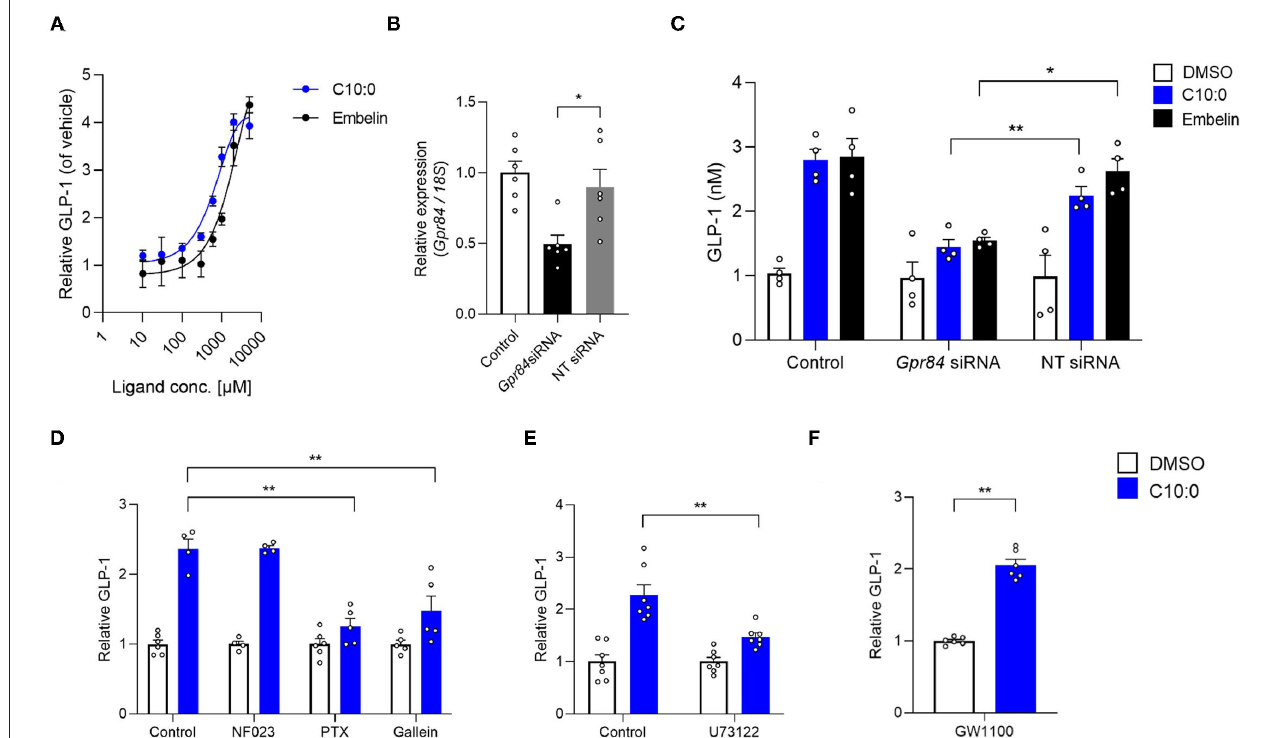
FIGURE 4 | Medium-chain fatty acid (MCFA) decanoate (C10:0) promotes GLP-1 secretion via GPR84 in STC-1 cells. (A) STC-1 cells were treated with various doses of C10:0 and GPR84 agonist embelin (0.01, 0.03, 0.1, 0.3, 0.6, 1, 2, and 5mM). GLP-1 concentration in the culture medium was measured ( n = 6). Data are represented as relative to the GLP-1 protein levels in non-stimulated cells. (B) RNAi efficiency by Gpr84 siRNA ( n = 6). Gpr84 expression is represented as relative to its expression in the untreated control cells. (C) Inhibitory effects of Gpr84 siRNA on GLP-1 secretion in cells treated with C10:0 (1mM) and embelin (1mM; n = 4). (D–F) Cells were stimulated with C10:0 (500 µ M) after pretreatment with NF023 (10 µ M), PTX (1 µ g/mL), Gallein (30 µ M), U73122 (1 µ M), or GW1100 (10 µ M) for 20min ( n = 4–6). Data are represented as relative to the GLP-1 protein levels in C10:0 non-stimulated cells. ** P < 0.01; * P < 0.05 (Tukey-Kramer test).